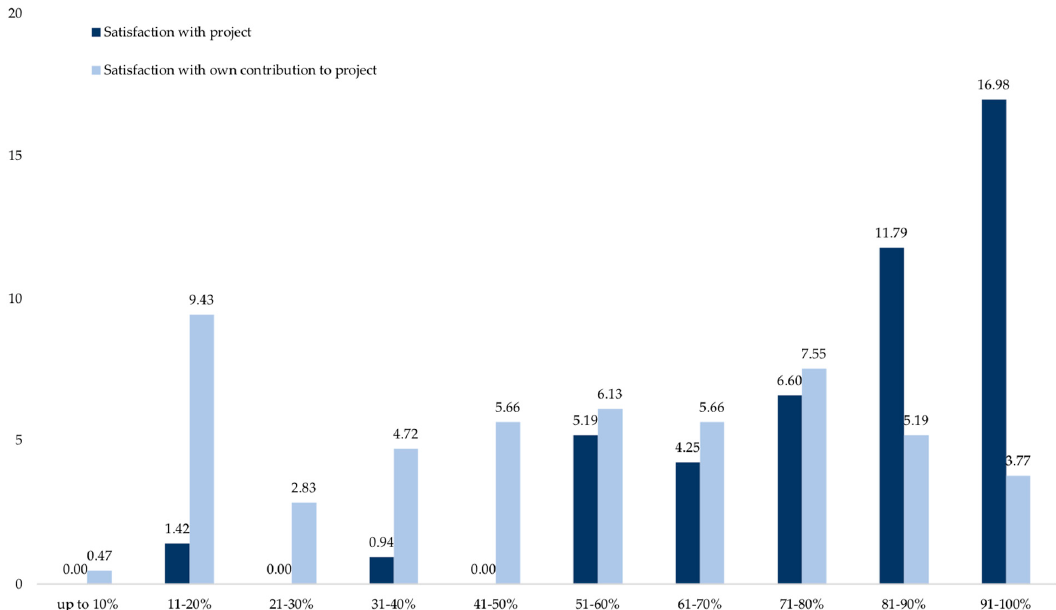
Figure 3. Satisfaction with the overall project and personal contribution to project in percent ( N = 115). Eleven-point scale from 0 = 0%, 1 = up to 10%, to 11 = 91–100%; mean values.